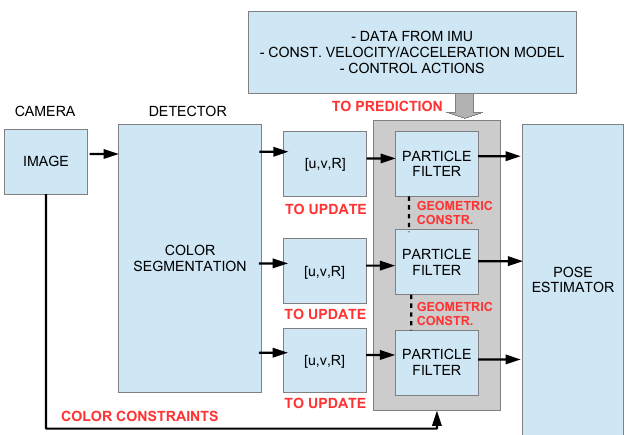
Figure 7. Proposed approach for tracking the target in video captures and to estimate the relative pose of the AUV with regard to that target. In the Figure, the elements u , v and R are the position of the blob on the image and the blob radius on the